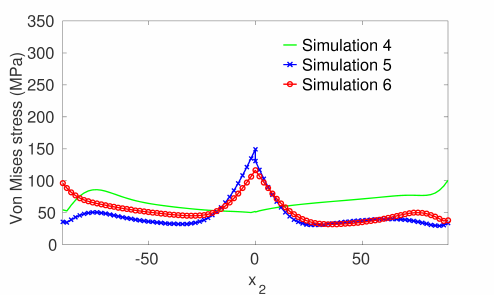
Figure 10. Profiles of Von Mises stress along x 2 through point B (0,0,0) obtained by FE simulations 4, 5 and 6.